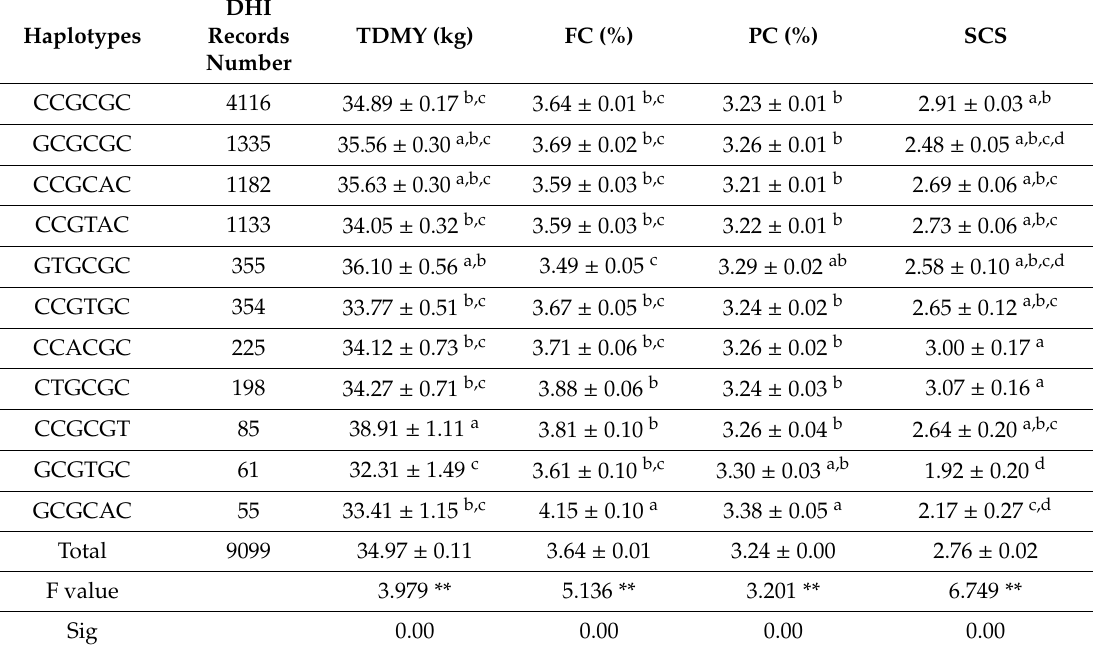
Table 6. E ff ects of haplotypes for SNPs on milk production traits and